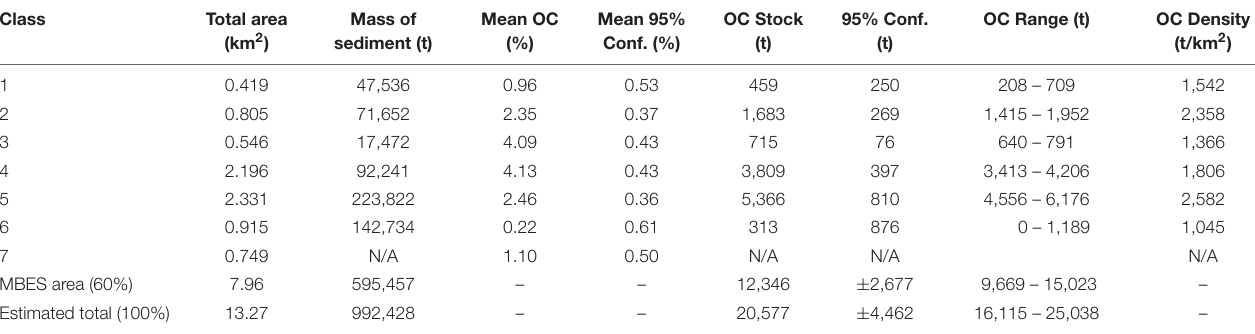
TABLE 4 | Mass of sediment and the calculated mass of OC held within each class for the top 10 cm from Loch Creran using sediment specific DBD values. Class Total area